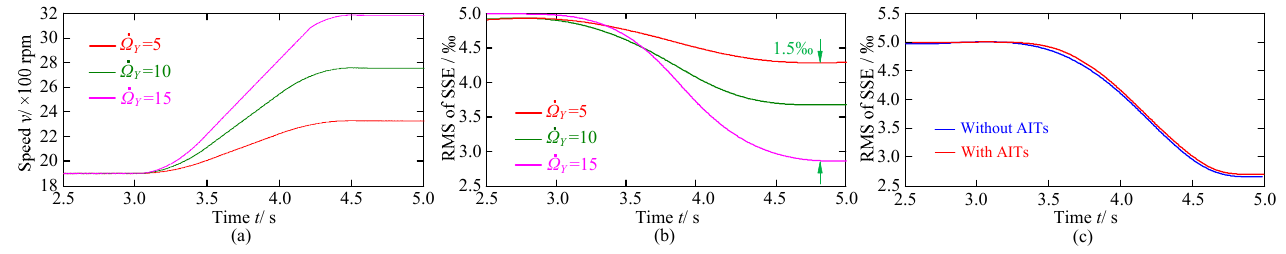
Figure 23. Speed and RMS value of SSE: ( a ) speed of PMSM under different rotating accelerations; ( b ) RMS values of SSE under different rotating accelerations; ( c ) RMS values of SSE with or without AITs.